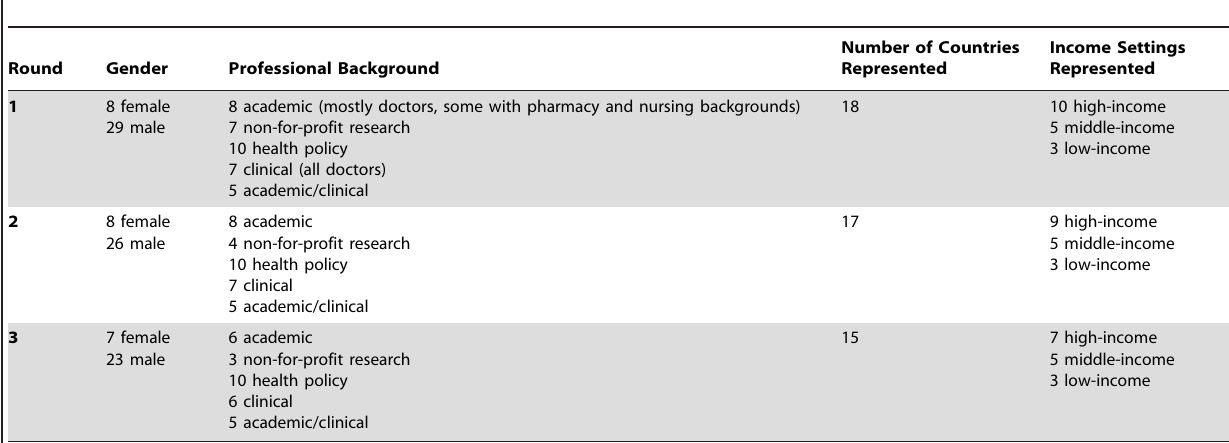
Table 1. Key participant characteristics of experts in all three rounds of the modified Delphi exercise.